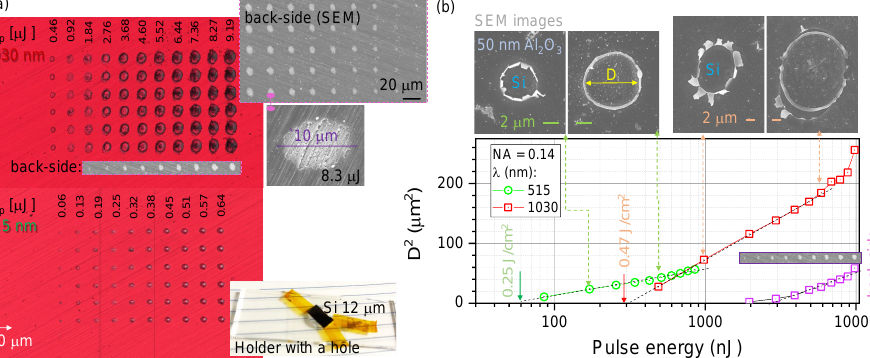
Figure 3. ( a ) Optical reflection image of single-pulse irradiated sites at NA = 0.14 focusing on a 50 nm Al 2 O 3 -coated 12 µ m-thick Si (inset photo) at different pulse energies E p (on the sample) and wavelengths λ = 1030 nm and 515 nm. The SEM image insets show the back-side damage of the 12 µ m-thick Si. ( b ) Ablation threshold of 50 nm-thick Al 2 O 3 film on 12 µ m-thick Si determined from the D 2 ∝ lg ( E p ) dependence for two wavelengths λ = 1030,515 nm at NA = 0.14 focusing; E p was measured on the sample. The diameter of the back-side contrast change in the SEM image is plotted on the same D 2 dependence (for λ = 1030